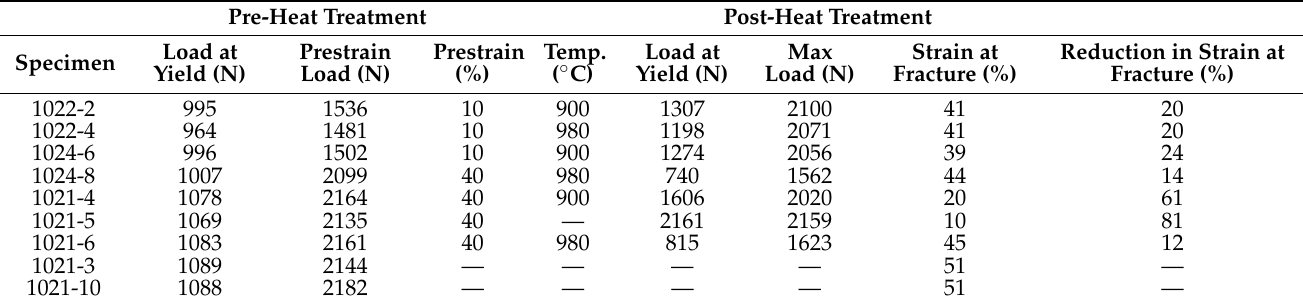
Table 4. Pre- and post-heat treatment specimens’ loads at yield, maximum loads, and fracture elongation percentages. Pre-Heat Treatment Post-Heat Treatment